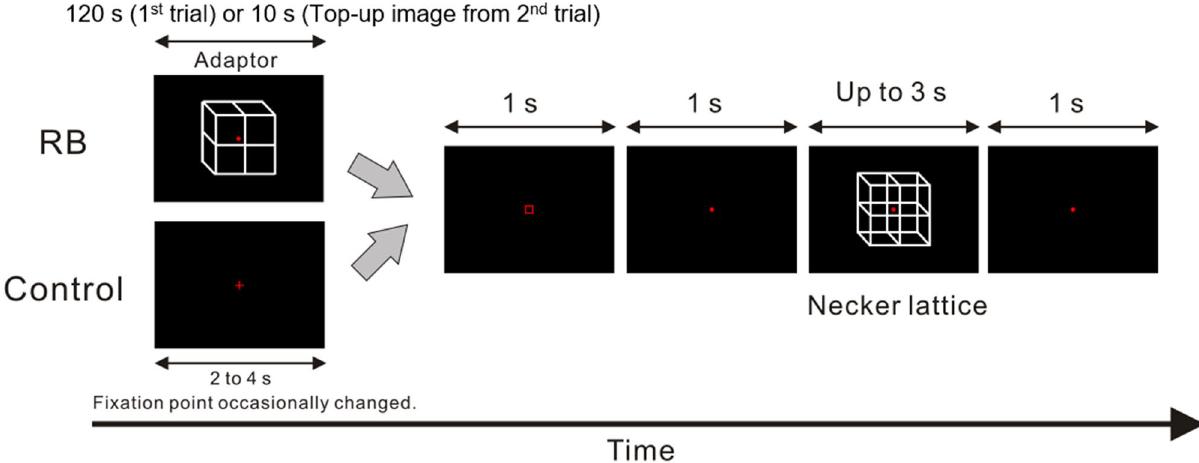
Figure 1. Time course of stimulus presentation in one trial. The stimulation scheme for one trial for both the reverse-bias (RB) condition and the Control condition is shown in figure. In the first trial of each session for the RB condition, an unambiguous adaptor (a lower-right-facing lattice) was initially presented for 120 s to induce the reverse-bias effect for a subsequently presented Necker lattice. Participants were asked to respond to a change in the fixation point during the presentation of the adaptor to maintain fixation on the adaptor. They were then required to report an initial perceived facing-orientation of the Necker lattice following its onset. From the second to the last trial in each session, the adaptor appeared for 10 s at the beginning of each trial to prevent reduction of the reverse-bias effect throughout the session (this shortly-presented adaptor was set as the top-up image). In the Control condition, the adaptor and the top-up image were not presented (see “Methods” for emergence of the reverse-bias effect. Following the adaptor, the blank image with the red square frame and that with the fixation point immediately and consecutively appeared in this order for 1 s each. The presentation of the square frame was set to indicate the end of the detection task of the fixation change. Presentation of the square frame was also expected to equally control for participants to anticipate the timing of the forthcoming Necker lattice under both the RB and the Control conditions; the time interval between the presentation of the rectangle and the Necker lattice was identical across conditions. The Necker lattice (a bistable image that can induce either a lower-right-facing or upper-left-facing lattice) was then presented. The mean luminance of the Necker lattice was 3.24 cd/m 2 . To effectively induce the reverse-bias effect, the size of the Necker lattice was the same as that of the preceding adaptor, and the spatial position at which the Necker lattice was presented was identical to that at which the adaptor was presented. When the Necker lattice was presented, participants were asked to report a current percept of the Necker lattice by pressing the response button in front of them; pressing the left arrow key for a percept of the upper-left-facing lattice and the right arrow key for a percept of the lower- right-facing lattice. The Necker lattice continuously appeared up to 3 s unless the participants reported its initial percept. When the perceptual report was obtained, the presentation of the Necker lattice automatically ceased. A blank image with the fixation point lasted for 1 s between trials. Based on a previous behavioral study 39 , a top- up image was employed to avoid reduction of the reverse-bias effect throughout the trials. At the beginning of each trial from the second to the last, the top-up image identical to the adaptor used in the first trial was instead presented for 10 s. The spatial position at which the top-up image was presented was the same as that at which the adaptor was presented. The fixation point of the top-up image occasionally changed to the red cross, as in the adaptor of the first trial, and the participants were asked to respond to the change as in the task during the presentation period of the adaptor. The mean number of fixation changes during presentation of a top-up image was 1.41 ± 0.11 (SD) across participants. The scheme of image presentation was identical to that of the first trial after presentation of the top-up image. In the Control condition, the adaptor and the top-up stimulus did not appear, but a blank image lasting for 2–4 s (randomly selected) was instead presented prior to the presentation of the blank image with the red square frame. The fixation point of the blank image occasionally changed, similar to the adaptor/top-up image in the RB condition. The mean number of fixation changes during presentation of a blank image was 0.37 ± 0.02 (SD) across participants. The scheme of image presentation in the Control condition was identical to that in the RB condition except for the images presented prior to the presentation of the red square frame (see Fig. 1). The behavioral task in the Control condition was the same as that in the RB condition. Each condition consisted of 120 trials divided into 6 sessions. In the RB condition, the adaptor lasting for 120 s was presented for the first trial of each session. Participants were allowed to rest between sessions if needed.